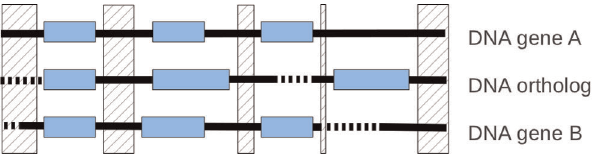
Figure 4. Processing of an alignment and conservation of informative signal of sequences. The hatched area is deleted area, blue boxes are exons (exons of retrieved orthologs come from prediction), bold black lines are DNA, and bold dotted lines are gaps.